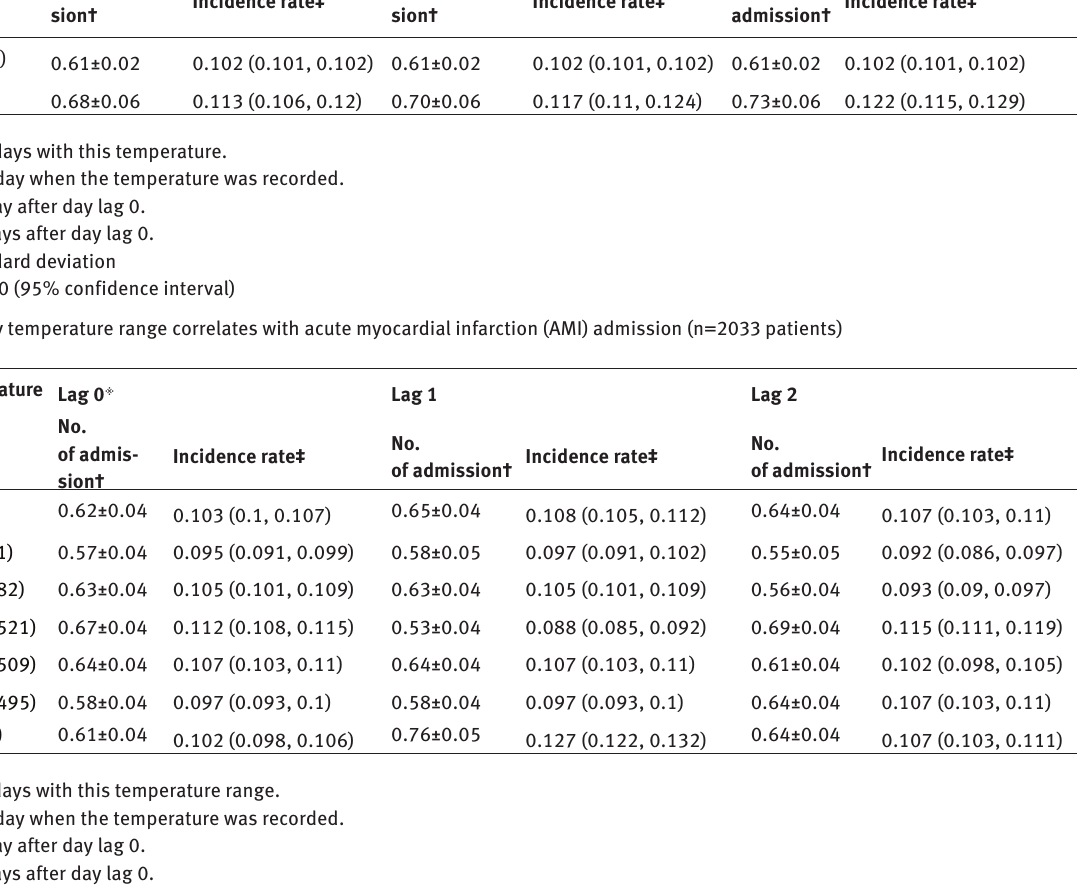
Table 4: Multivariate analysis of the temperature indices with acute myocardial infarction incidence (n=2033 patients)